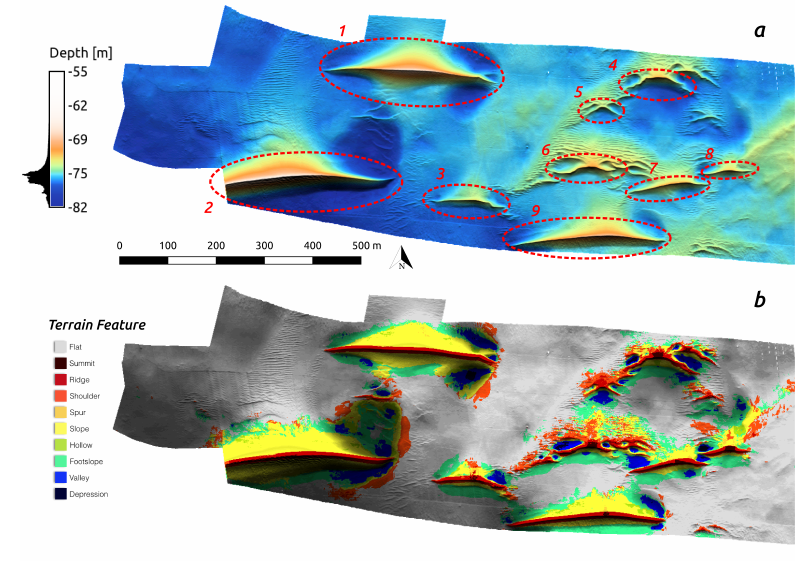
Figure 31. Control units ( a ); and Model C outputs ( b ), r.geomorphon parameters used: Outer search radius : 35, Inner search radius : 9, Flatness treshold ( degrees ) : 3.7, Flatness distance : 15. Color images draped over a shaded relief (azimuth of the sun in degrees to the east of north: 0 ◦ N , altitude of the sun in degrees above the horizon: 50 ◦